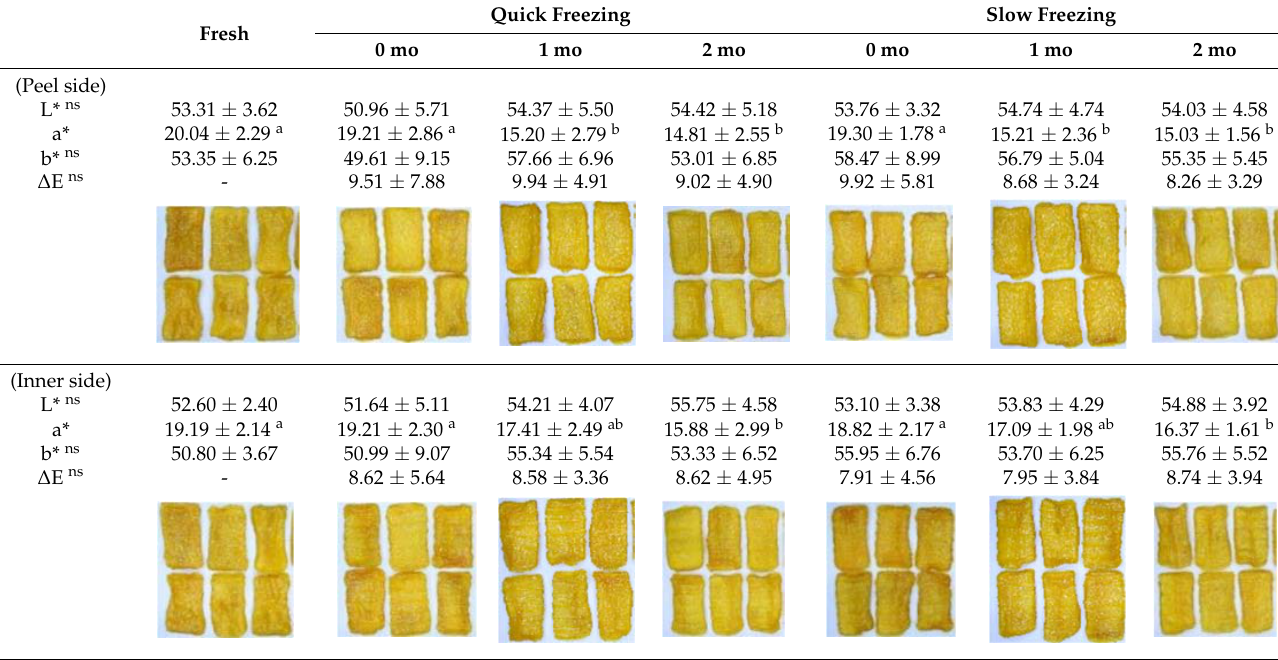
Table 4. Appearance and color parameters of osmotic hot air ‐ dried mango slabs.